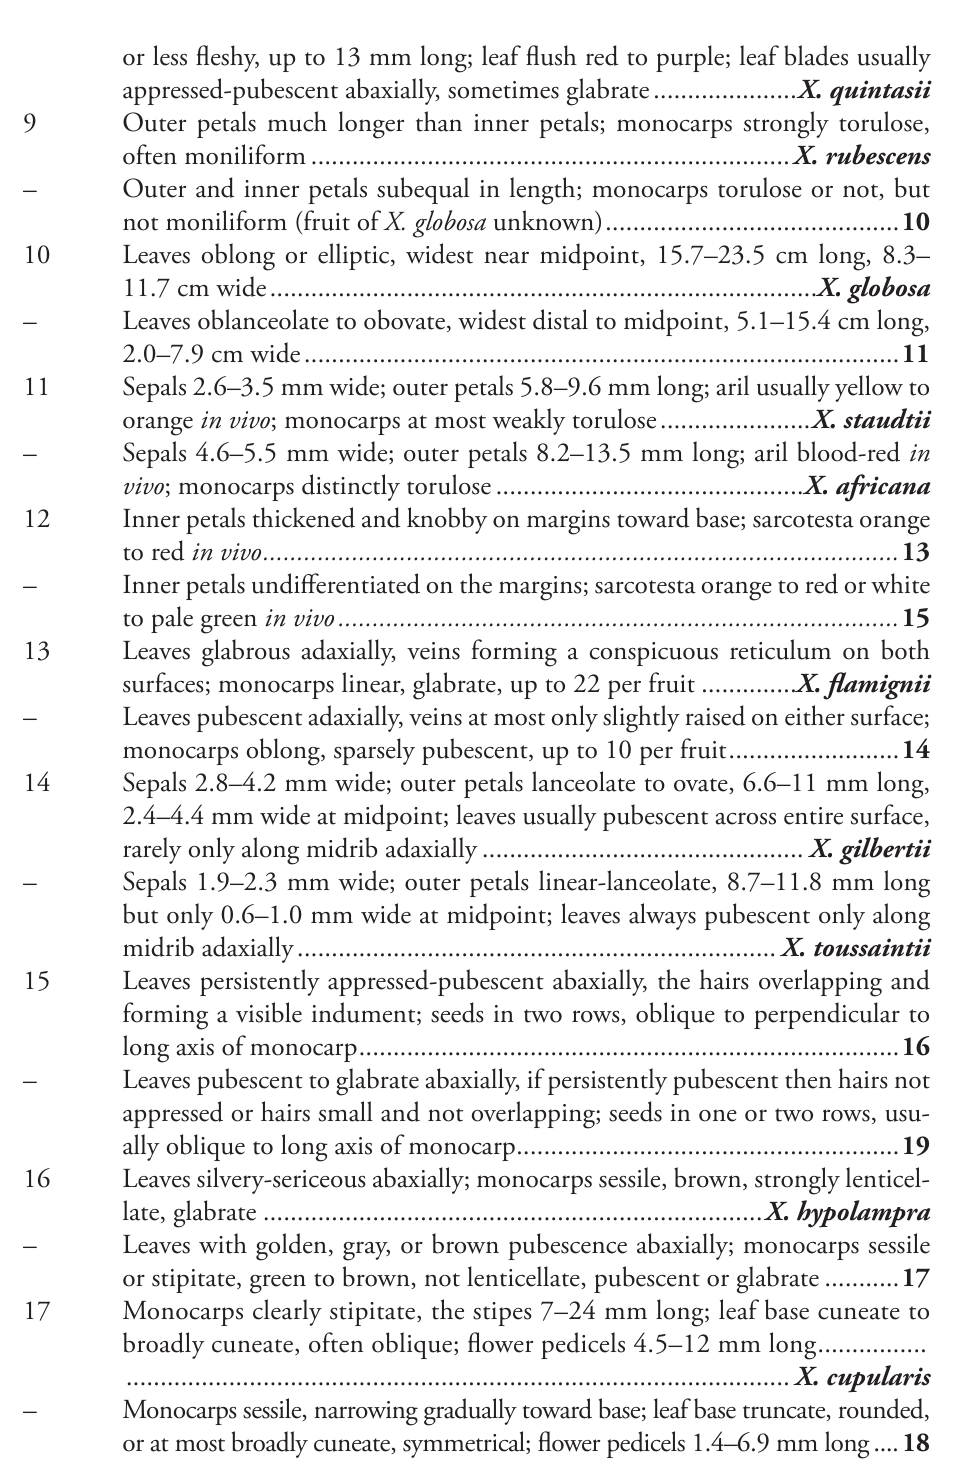
or less fleshy, up to 13 mm long; leaf flush red to purple; leaf blades usually appressed-pubescent abaxially, sometimes glabrate ..................... X. quintasii 9 Outer petals much longer than inner petals; monocarps strongly torulose, often moniliform ...................................................................... X. rubescens – Outer and inner petals subequal in length; monocarps torulose or not, but not moniliform (fruit of X. globosa unknown) ........................................... 10 10 Leaves oblong or elliptic, widest near midpoint, 15.7–23.5 cm long, 8.3– 11.7 cm wide ................................................................................ X. globosa – Leaves oblanceolate to obovate, widest distal to midpoint, 5.1–15.4 cm long, 2.0–7.9 cm wide ....................................................................................... 11 11 Sepals 2.6–3.5 mm wide; outer petals 5.8–9.6 mm long; aril usually yellow to orange in vivo ; monocarps at most weakly torulose ...................... X. staudtii – Sepals 4.6–5.5 mm wide; outer petals 8.2–13.5 mm long; aril blood-red in vivo ; monocarps distinctly torulose ............................................. X. africana 12 Inner petals thickened and knobby on margins toward base; sarcotesta orange to red in vivo ............................................................................................. 13 – Inner petals undifferentiated on the margins; sarcotesta orange to red or white to pale green in vivo .................................................................................. 15 13 Leaves glabrous adaxially, veins forming a conspicuous reticulum on both surfaces; monocarps linear, glabrate, up to 22 per fruit .............. X. flamignii – Leaves pubescent adaxially, veins at most only slightly raised on either surface; monocarps oblong, sparsely pubescent, up to 10 per fruit ......................... 14 14 Sepals 2.8–4.2 mm wide; outer petals lanceolate to ovate, 6.6–11 mm long, 2.4–4.4 mm wide at midpoint; leaves usually pubescent across entire surface, rarely only along midrib adaxially ............................................... X. gilbertii – Sepals 1.9–2.3 mm wide; outer petals linear-lanceolate, 8.7–11.8 mm long but only 0.6–1.0 mm wide at midpoint; leaves always pubescent only along midrib adaxially ...................................................................... X. toussaintii 15 Leaves persistently appressed-pubescent abaxially, the hairs overlapping and forming a visible indument; seeds in two rows, oblique to perpendicular to long axis of monocarp ............................................................................... 16 – Leaves pubescent to glabrate abaxially, if persistently pubescent then hairs not appressed or hairs small and not overlapping; seeds in one or two rows, usu- ally oblique to long axis of monocarp ........................................................ 19 16 Leaves silvery-sericeous abaxially; monocarps sessile, brown, strongly lenticel- late, glabrate ......................................................................... X. hypolampra – Leaves with golden, gray, or brown pubescence abaxially; monocarps sessile or stipitate, green to brown, not lenticellate, pubescent or glabrate ........... 17 17 Monocarps clearly stipitate, the stipes 7–24 mm long; leaf base cuneate to broadly cuneate, often oblique; flower pedicels 4.5–12 mm long ................ ................................................................................................. X. cupularis – Monocarps sessile, narrowing gradually toward base; leaf base truncate, rounded, or at most broadly cuneate, symmetrical; flower pedicels 1.4–6.9 mm long ....